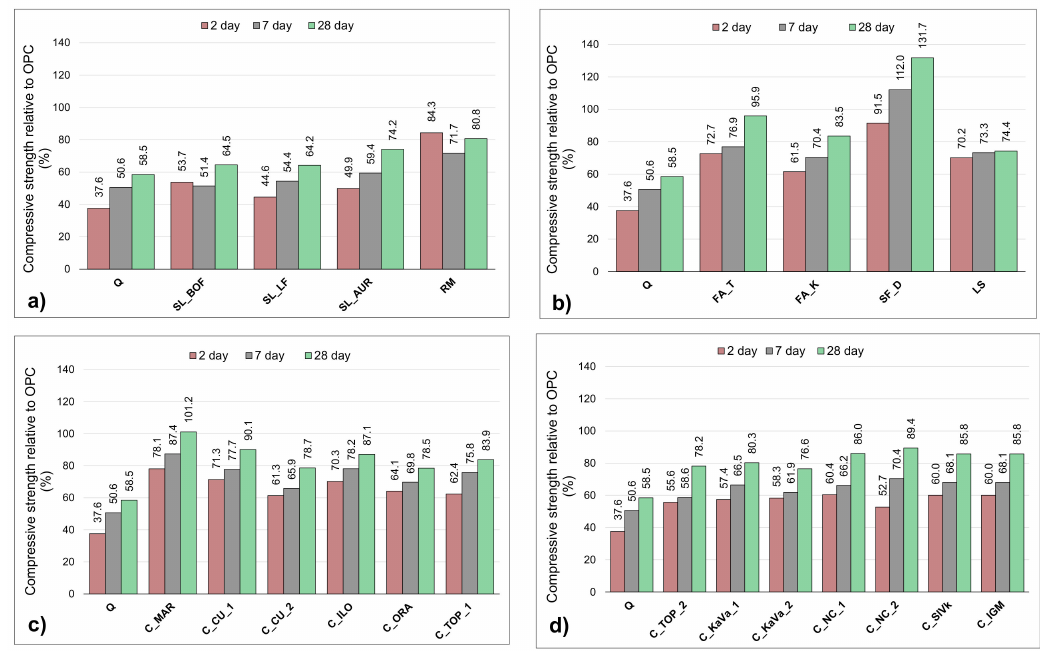
Figure 9. Compressive strength results of mortars with a 30% SCMs substitution relative to compressive strength of OPC sample: ( a ) slags, iron silicate fines and red mud ( b ) silica fume, limestone and fly ashes, ( c , d )